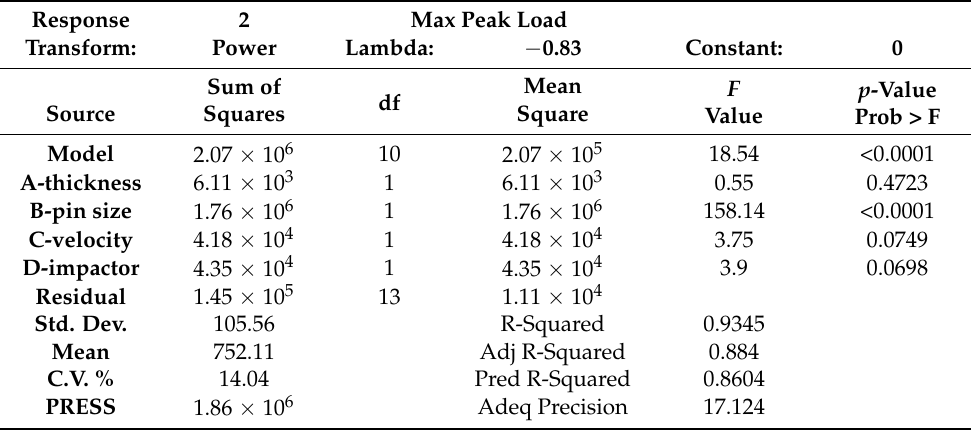
Table 4. ANOVA analysis for max peak load as the second response of DOE